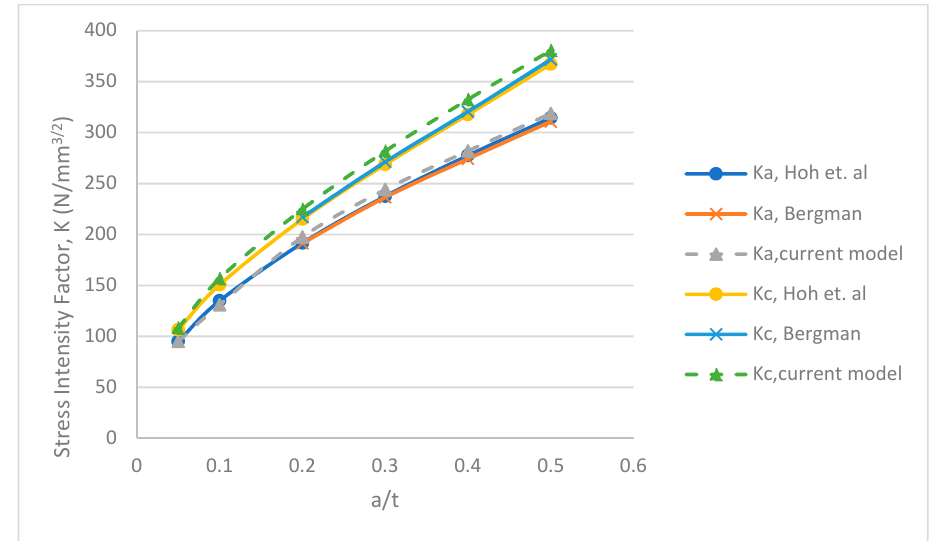
Figure 13. Comparison of SIFs at the deepest point ( K a ) and surface point ( K c ) for semi-elliptical surface cracks in plain pipe under tension for a/c = 1.